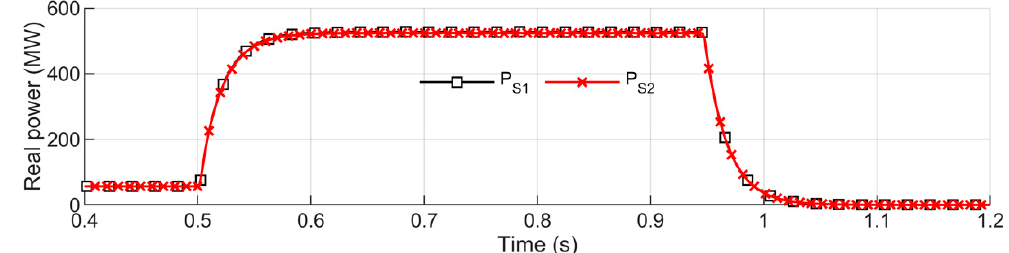
Energies 2020 , 13 , x FOR PEER REVIEW 14 of 16 Figure 27. Conducted power in HTS cables in case DCR and DOCR fail. Figure 27. Conducted power in HTS cables in case DCR and DOCR fail. Figure 27. Conducted power in HTS cables in case DCR and DOCR fail.